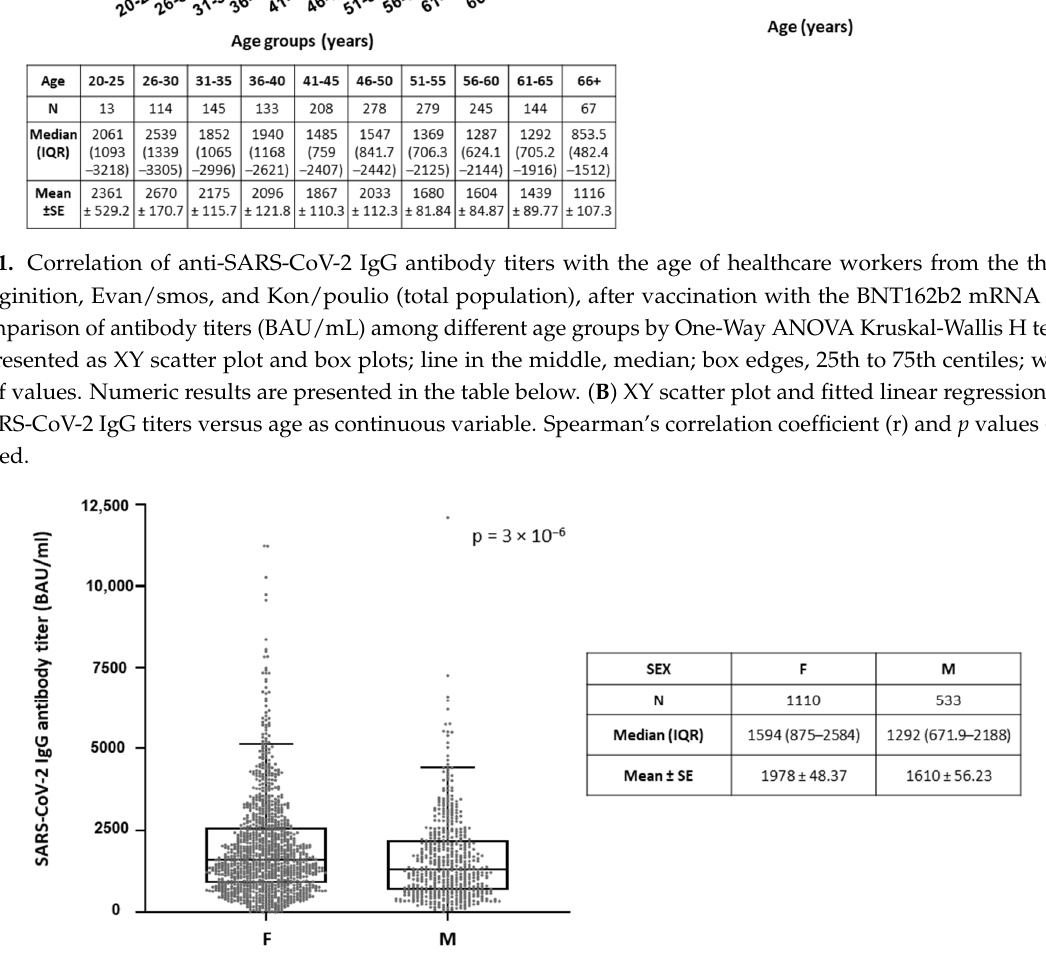
Figure 2. Comparison of antibody titers in men as compared to women. Data are represented as box plots; line in the middle, median; box edges, 25th to 75th centiles; whiskers, range of values. For the total population of vaccinees from Eginition, Evan/smos and Kon/poulio Hospitals, the significance of the difference between sexes was evaluated after cal ‐ culation of p value with Mann ‐ Whitney U test. Numeric results are presented in the table below.